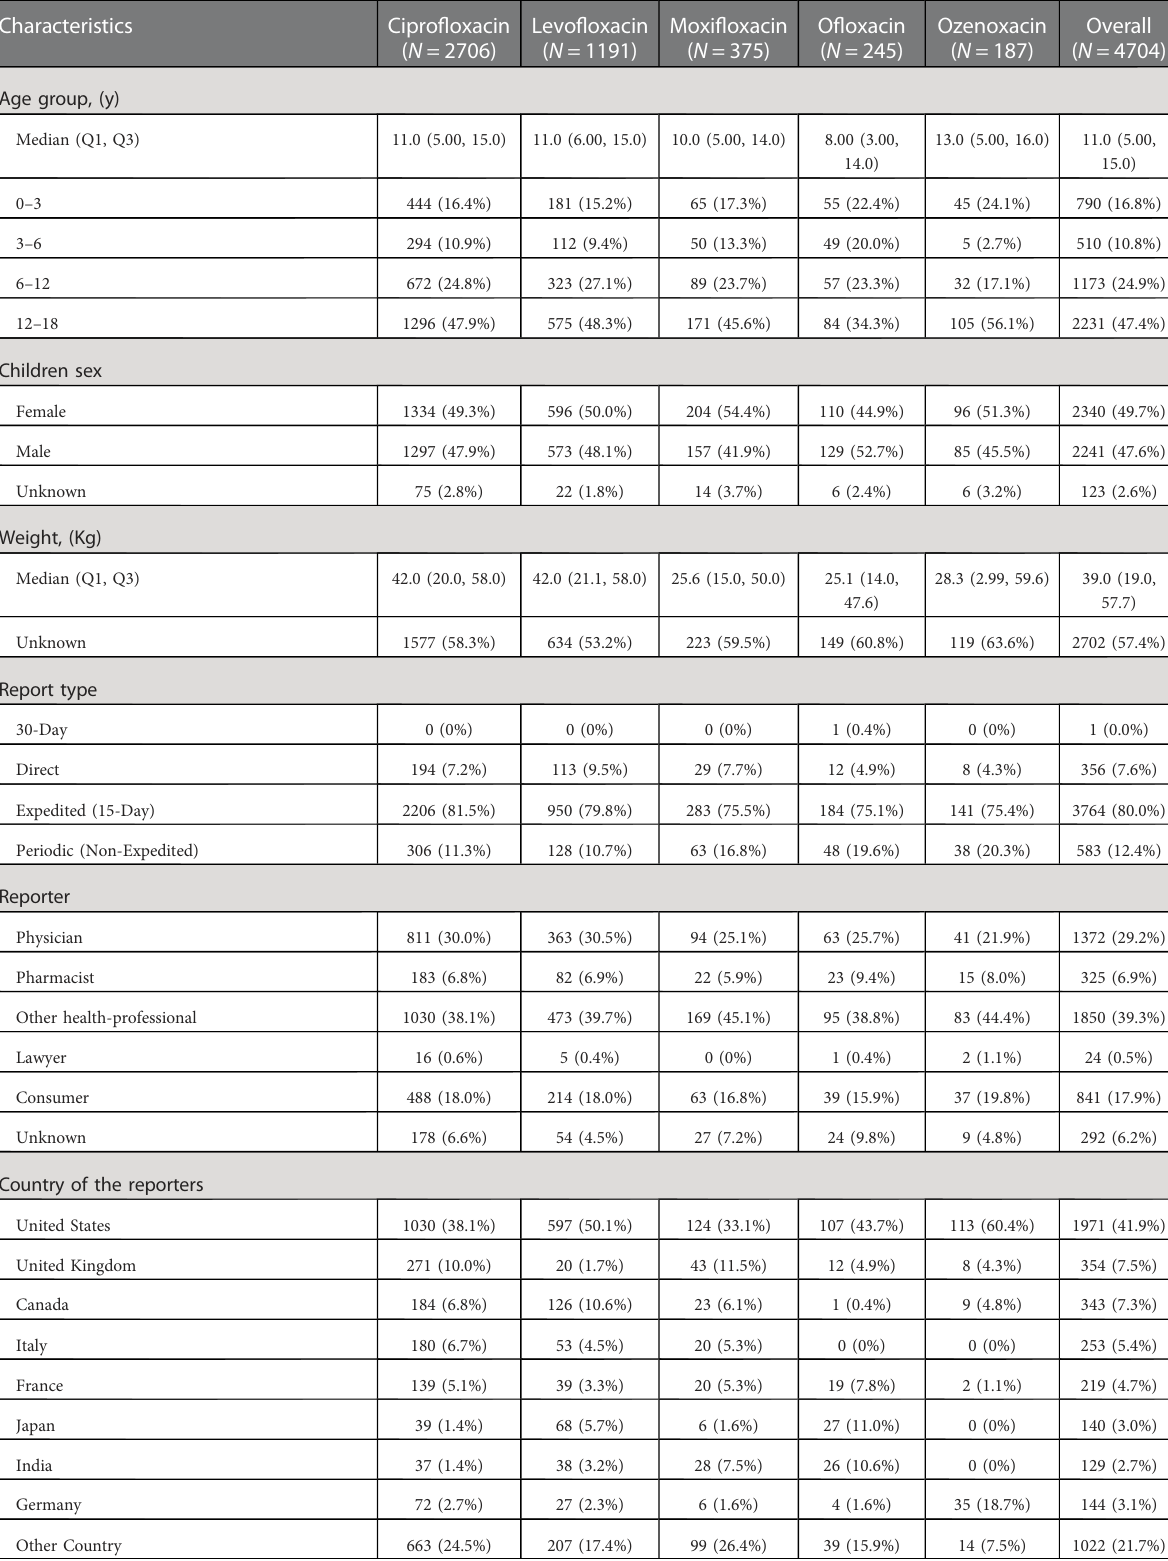
TABLE 1 The baseline characteristics of adverse events reports related to quinolones for children.